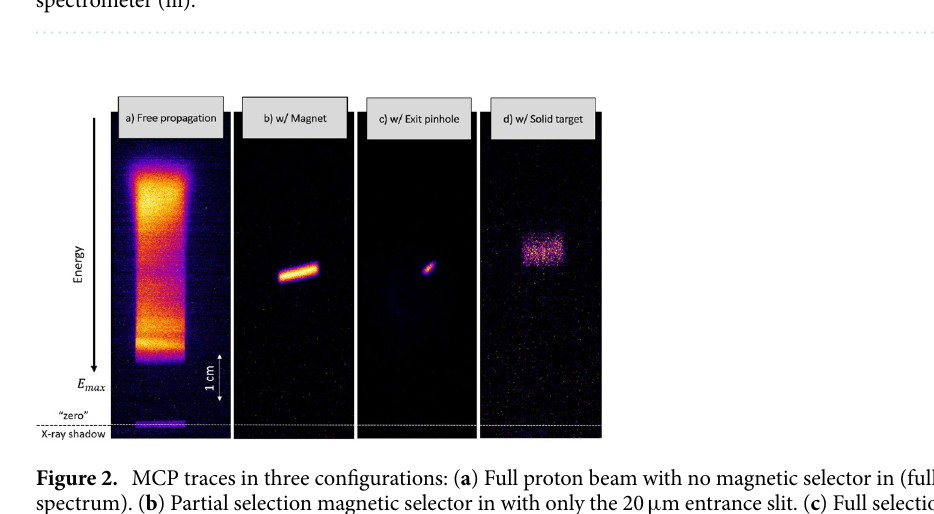
Figure 1. Scheme of the experimental setup. It can be divided into three stages: proton generation (i), energy selection using magnet based proton selector (ii) and proton energy measurement with the magnet spectrometer (iii).